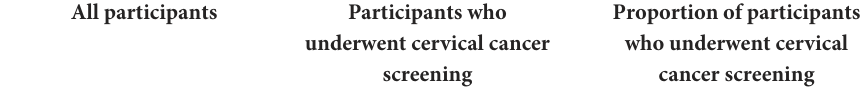
TABLE 1 Socioeconomic and other characteristics of all study participants and those who underwent cervical cancer screening in 2013 and 2018. Characteristic All participants Participants who